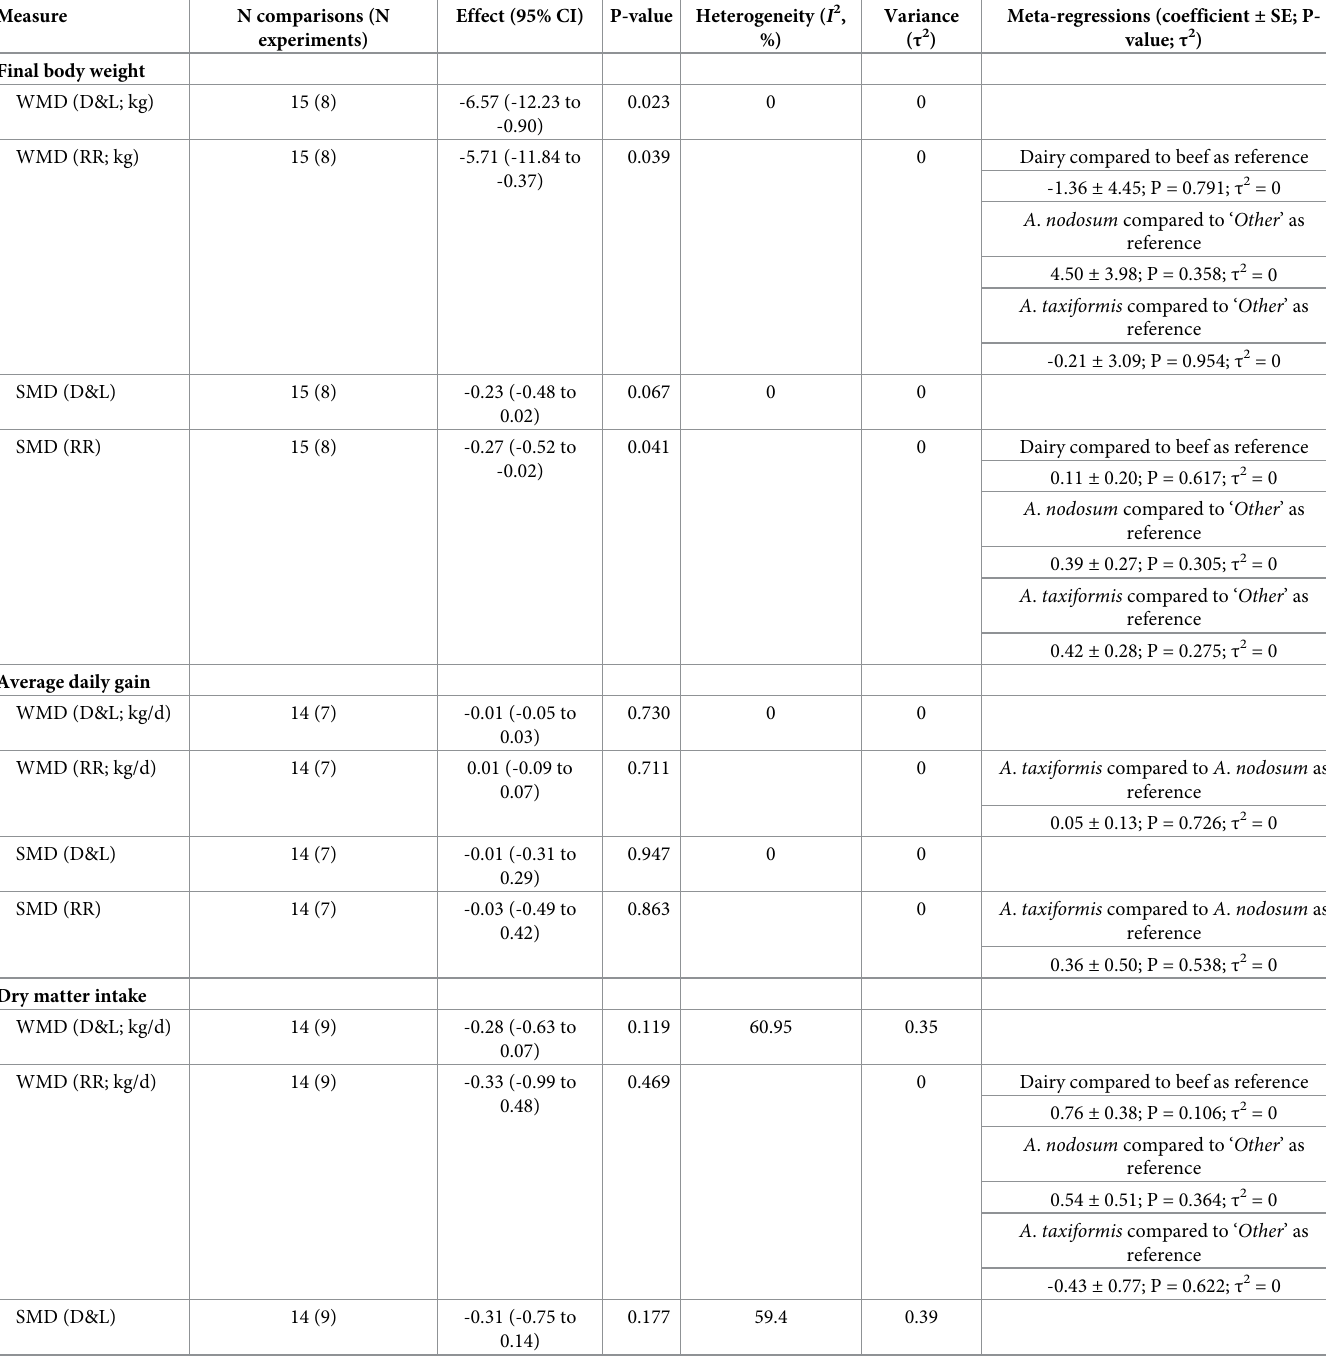
Table 4. Summary of the meta-analysis using classical meta-analysis methods for the effects of seaweed on production